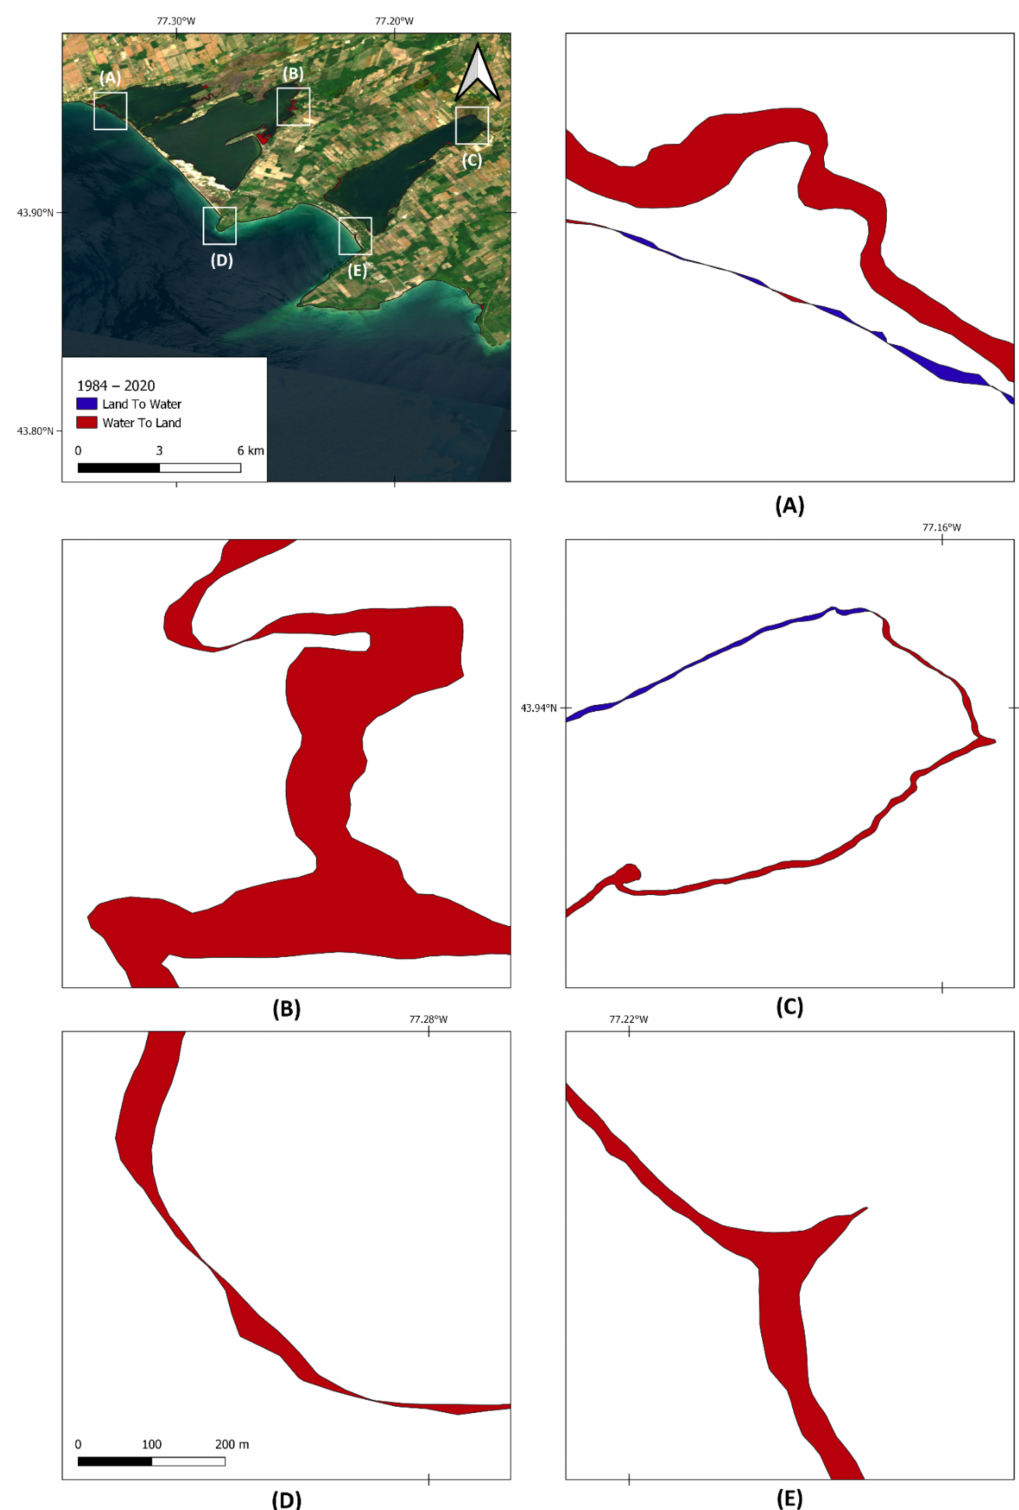
Figure 4. Total coastal erosion and accretion from 1984 to 2020. Two parts are shown with more details from the adjacent Lake Ontario coasts ( D , E ), one part at the very end of the East Lake ( C ), one part at the eastern side of West Lake ( B ), and another zone at the narrow section of the baymouth dune between Lake Ontario and West Lake ( A